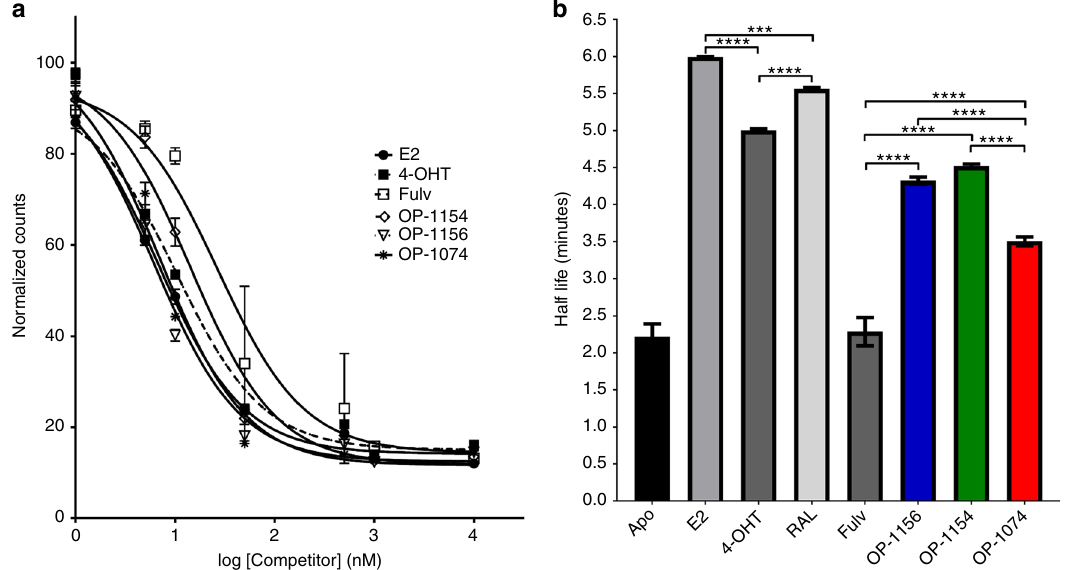
Fig. 4 Ligand binding af fi nities and the in fl uence of ligand on H12 mobility. a , Competitive binding af fi nity assay of compounds binding to ER α LBD. Experimental data points are mean + / − s.e.m. of triplicate samples in a representative experiment. Curves were fi t using a one-site fi t-log model (IC 50 ) in GraphPad Prism with R 2 of fi ts were ≥ 0.97. The IC 50 values were 6.71 ± 0.06 nM for E2, 10.46 ± 0.06 nM for 4-OHT, 26.88 ± 0.07 nM for Fulv, 14.3 ± 0.06 nM for OP-1154, 6.13 ± 0.06 nM for OP-1156, and 7.03 ± 0.05 nM for OP-1074. b , Measured half-lives of ER α -ligand complexes in a trypsin-coupled fl uorescence polarization assay of ER α LBD helix 12 mobility. *Denotes statistical signi fi cance between bars (**** for p < 0.0001, *** for p < 0.0001 – 0.001) using one-way ANOVA analysis. No signi fi cant differences were observed between Apo and fulvestrant or OP-1154 and OP-1156. Experimental data points are mean + / − s.d. of triplicate samples in a representative